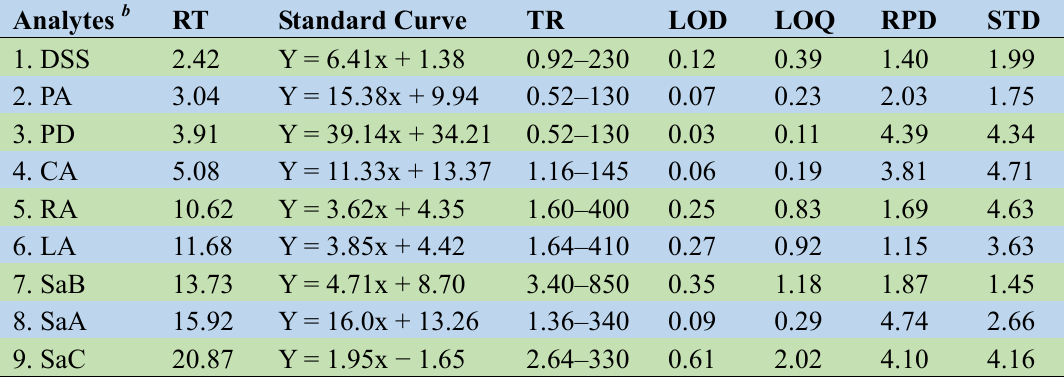
Table 1. Results of calibration curve and method validation for each analyte a